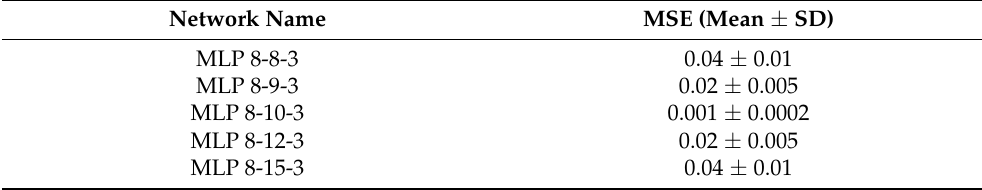
Table 4. MSE values for used